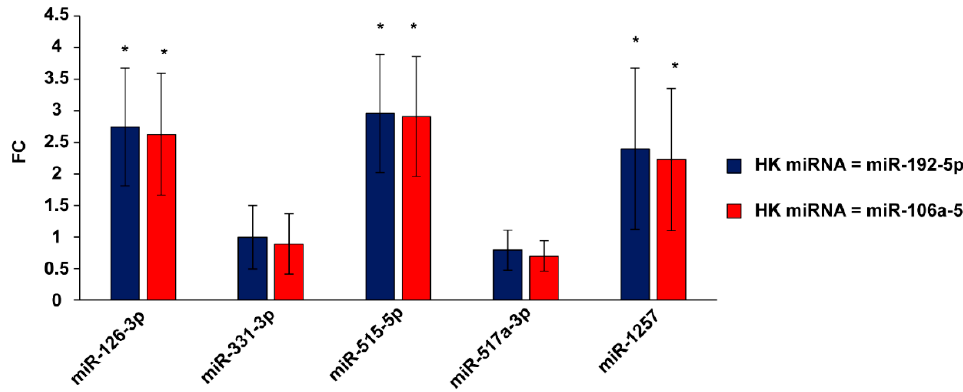
Figure 2. Expression of candidate DE miRNAs in U87MG overexpressing circSMARCA5. Data are reported as fold-change (FC) of the expression of candidate DE miRNAs in U87MG transfected with pcDNA3_circSMARCA5 vs. NCs. Red and blue bars show FC calculated by using miR-106a-5p and miR-192-5p as endogenous control (HK), respectively. The * p -value < 0.05 ( n = 3, Student’s t -test).